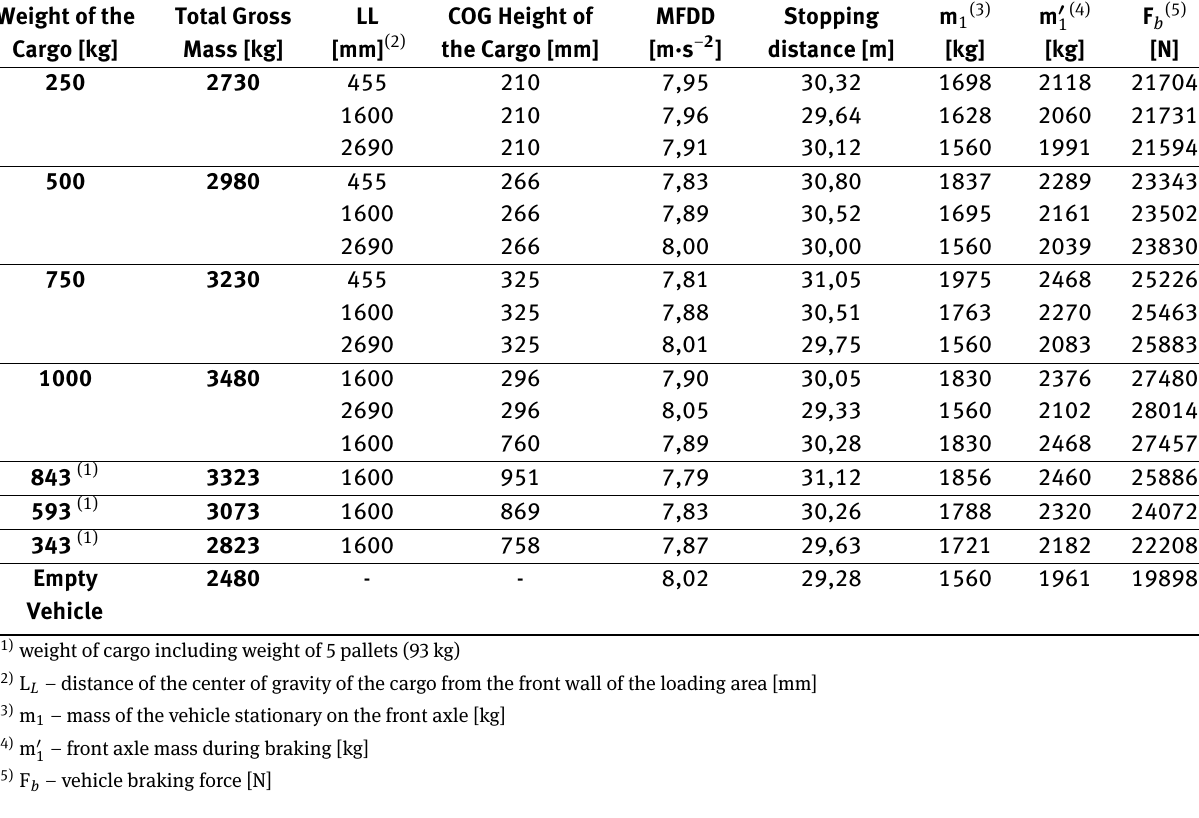
Table 1: Measured and calculated data recorded during braking tests Source: Authors Weight of the